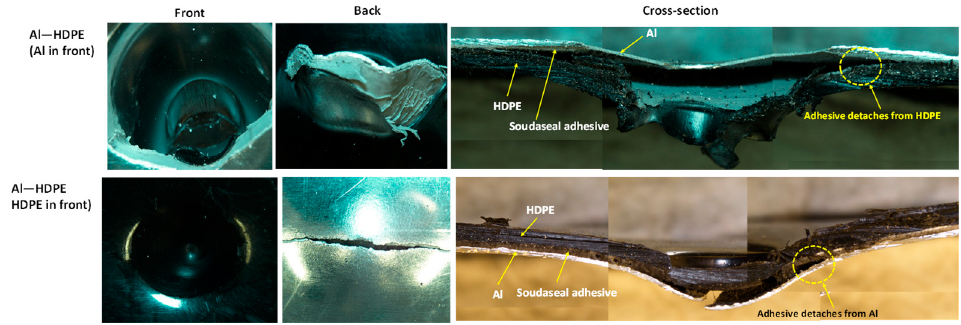
Figure 10. Failure modes of bilayer laminates under the blunt indenter.